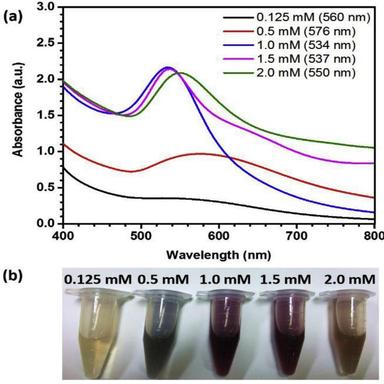
(a) UV–vis spectra of AuNPs synthesized using Lonicera japonica flower extract at different concentration of metal salt (HAuCl4: 0.125, 0.5, 1, 1.5, and 2 mM) and (b) color changes after 2 min reaction incubation (from left to right: 0.125, 0.5, 1, 1.5, and 2 mM). (For interpretation of the references to color in this figure legend, the reader is referred to the Web version of this article.)